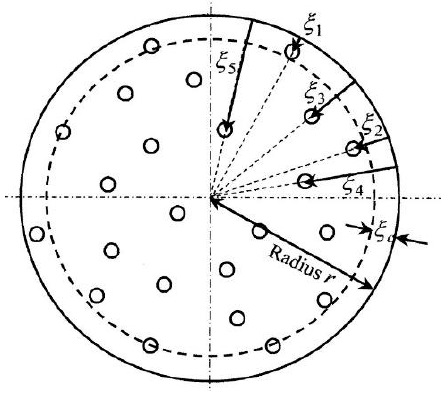
Figure 5. Definition of inclusion depth from surface.